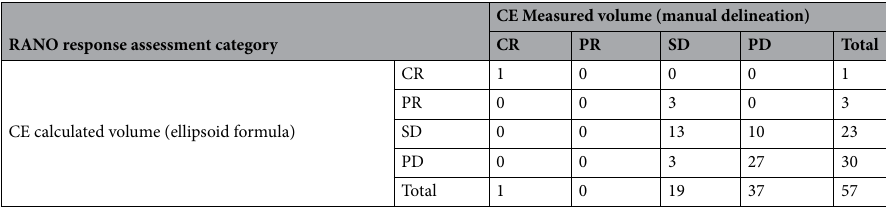
Table 2. Agreement in the RANO response assessment category between the two methods. CE contrast- enhancement; CR complete response; PD progressive disease; PR partial response; SD stable